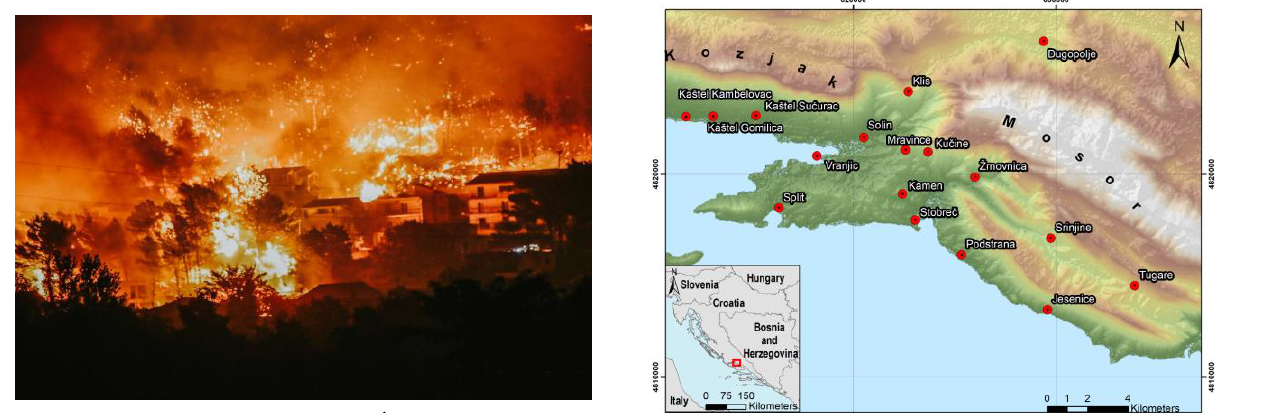
Figure 1. Fire in the Split surrounding (source/author: Damira Kalajdzic) Figure 2. Study area - City of Split